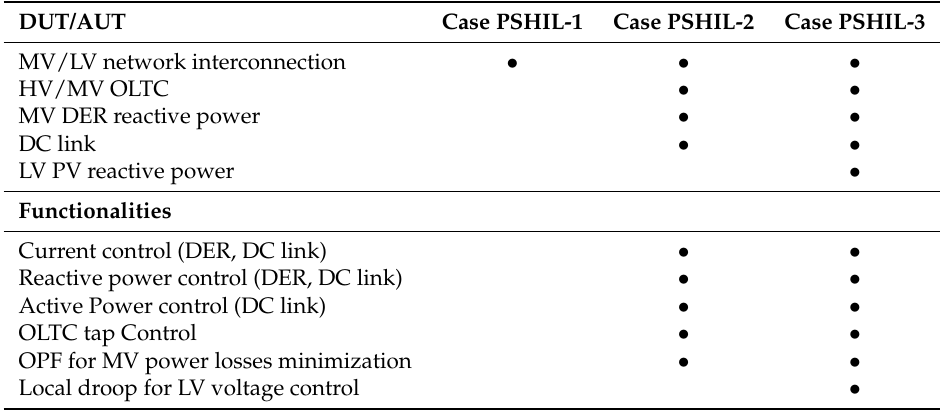
Table 4. DUT/AUT and functionalities of the test